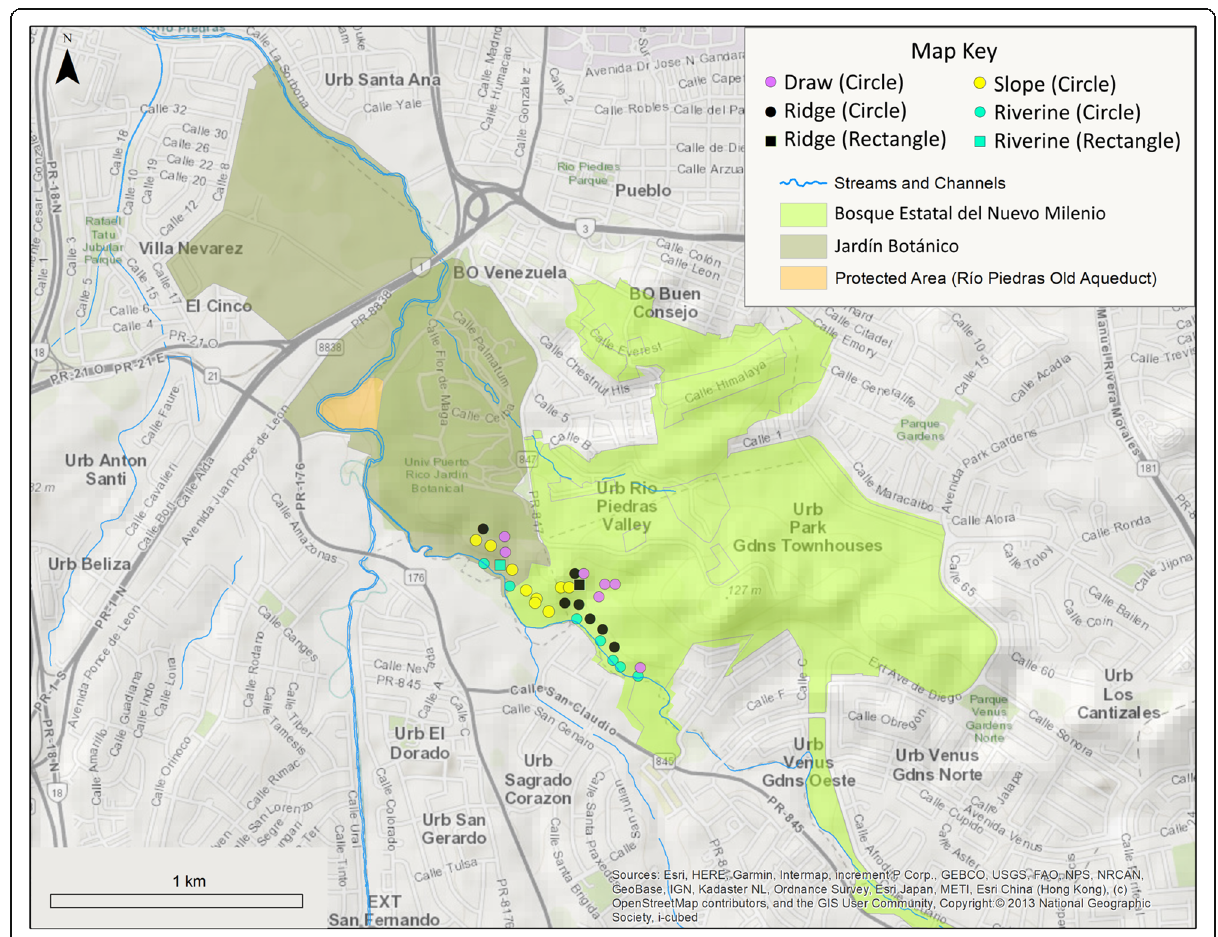
Fig. 1 Map of study plots within the Jardín Botánico and the Bosque Estatal del Nuevo Milenio, in Río Piedras Puerto Rico. Symbols indicate the shape of the sampling plot; colors indicate landform type: riverine (teal), slope (yellow), draw (purple), and ridge (black). Map was created using ArcGIS (ESRI)